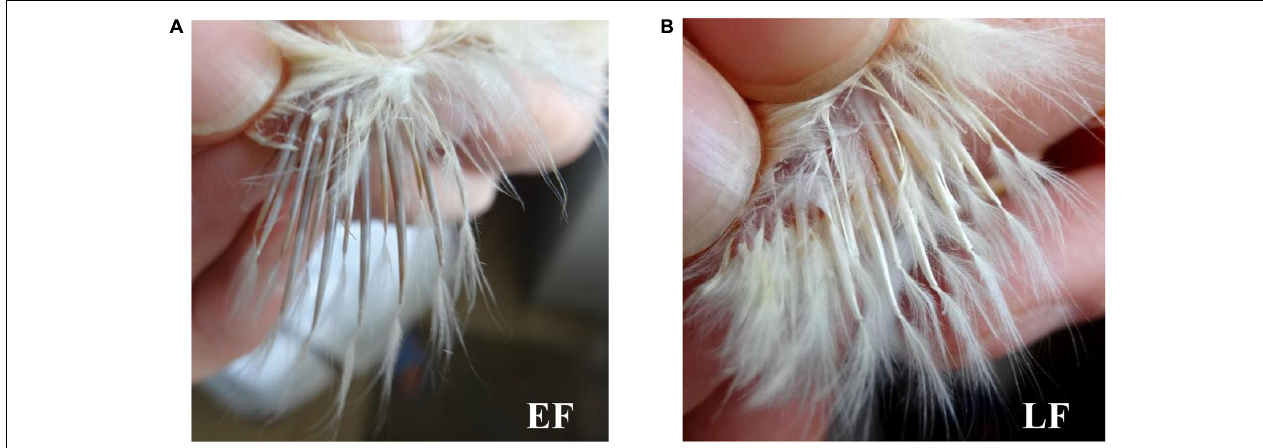
FIGURE 1 | Chicken feather rate phenotypes. (A) Chicken early-feathering phenotype. (B) Chicken late-feathering phenotype. One-day-old chicks with primary feathers longer than primary-covert feathers by more than 2 mm were identified with the early-feathering phenotype, otherwise, they would be identified with the late-feathering